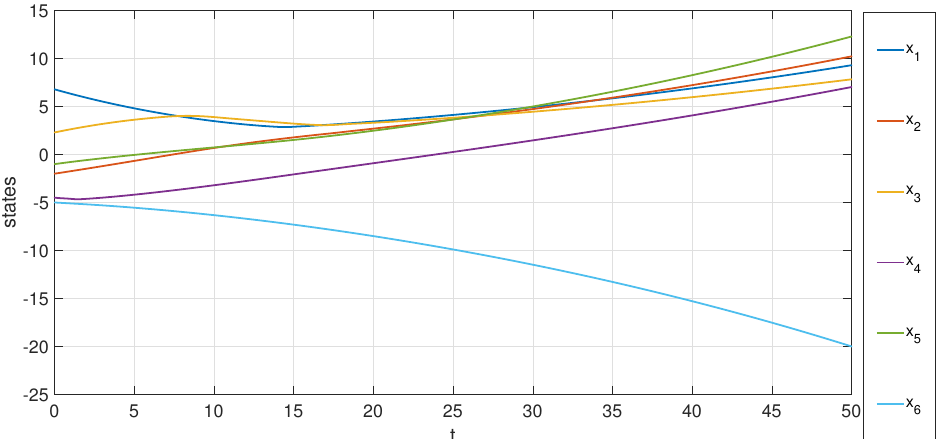
Figure 12. Simulation resultsrelating to the topology in Figure